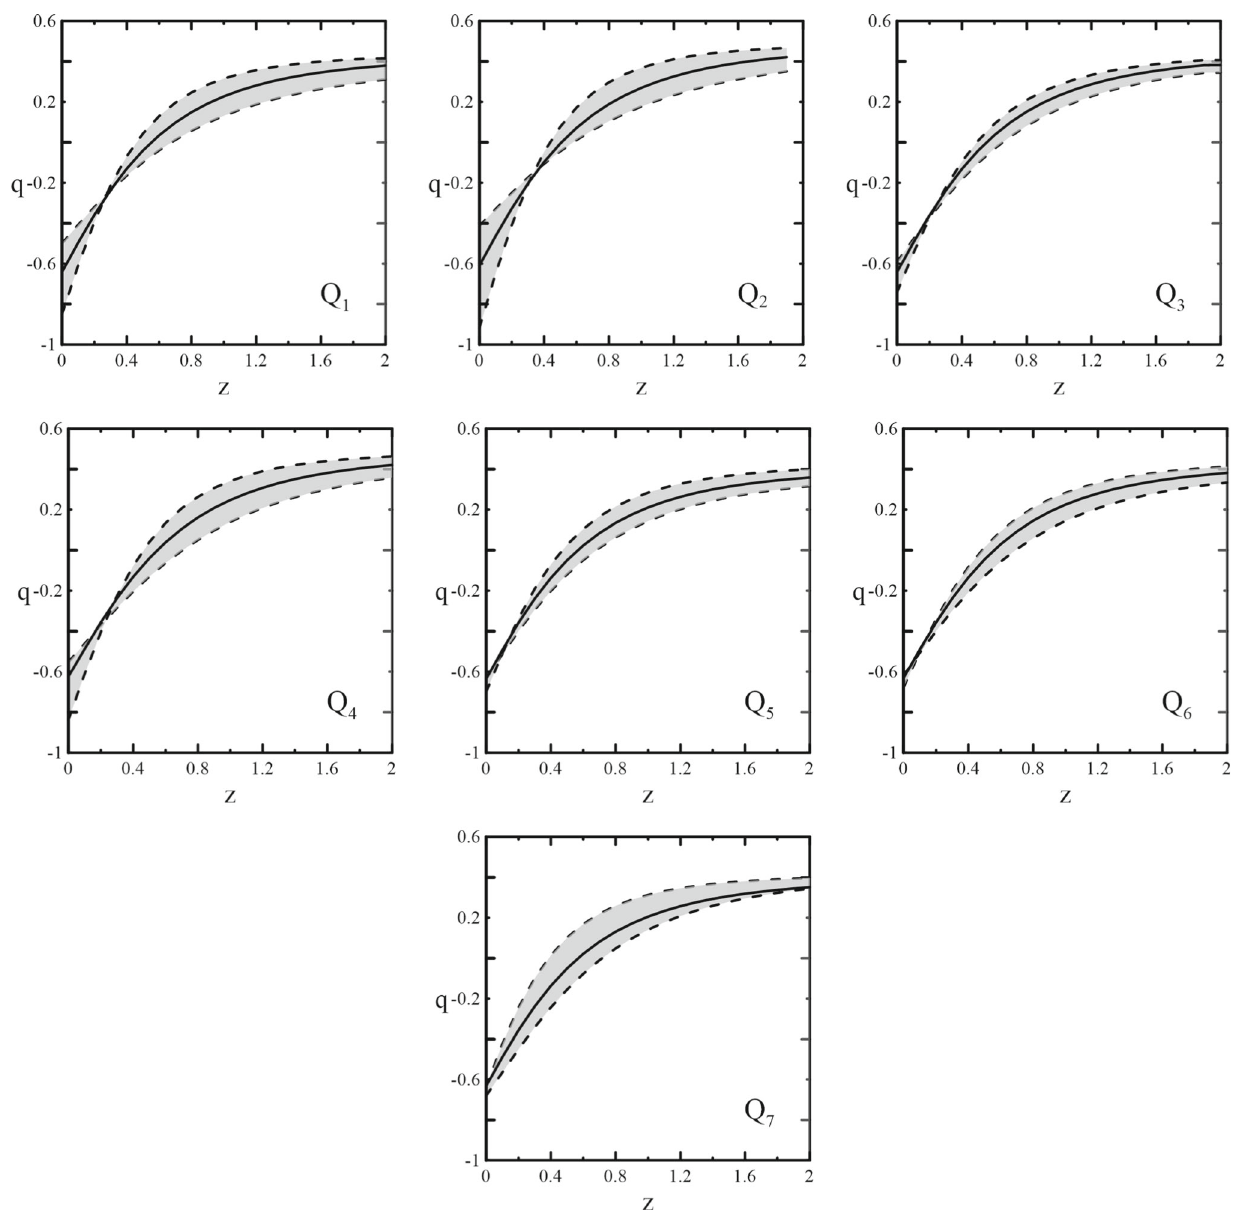
Fig. 1 The evolution of the deceleration parameter in terms of redshift for HRDE model (Eqs. (15) and (16)) with the corresponding 1 σ inter- val level according to the best fitted value listed in Tables 2 and 3 and